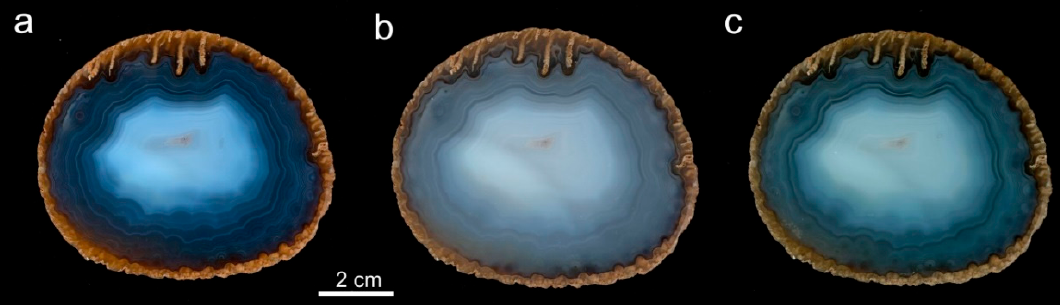
Figure 31. Aging of agate accompanied by loss of distinct banding and blue color demonstrated by an agate sample from Soledade, Rio Grande do Sul (Brazil): ( a ) freshly cut and polished agate with deep blue color and distinct banding; ( b ) the same agate after 3 years at room temperature and under natural light; ( c ) the agate after 6 weeks storage in water.